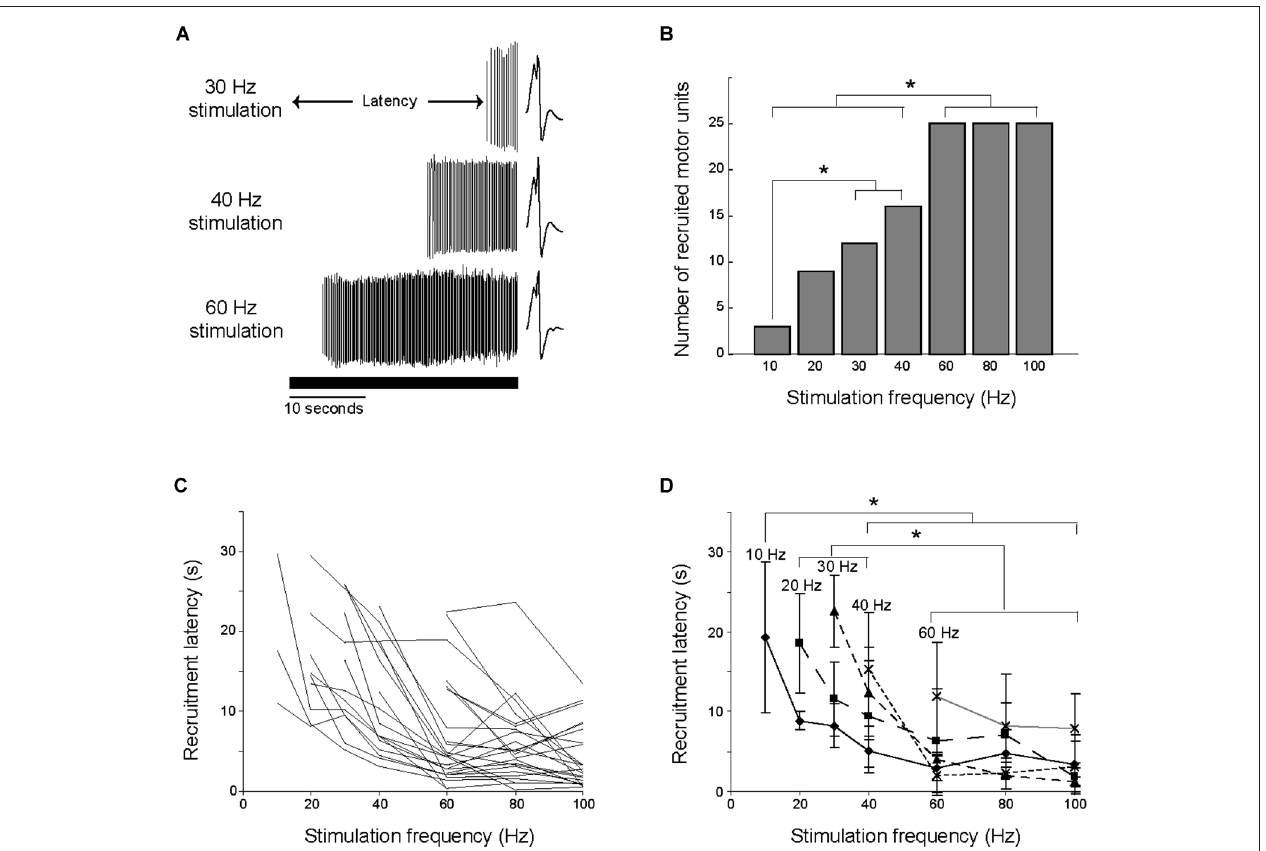
with stimulation frequency is illustrated for each of the 25 motor units. The minimal stimulation frequency required to recruit each motor unit varied. (D) The 25 motor units were grouped by the minimal stimulation frequency required for their recruitment, and the average recruitment latencies were calculated for each group. Higher stimulation frequencies recruited motor units at shorter latencies, with significant differences ( ∗ p < 0.05) between the indicated stimulation